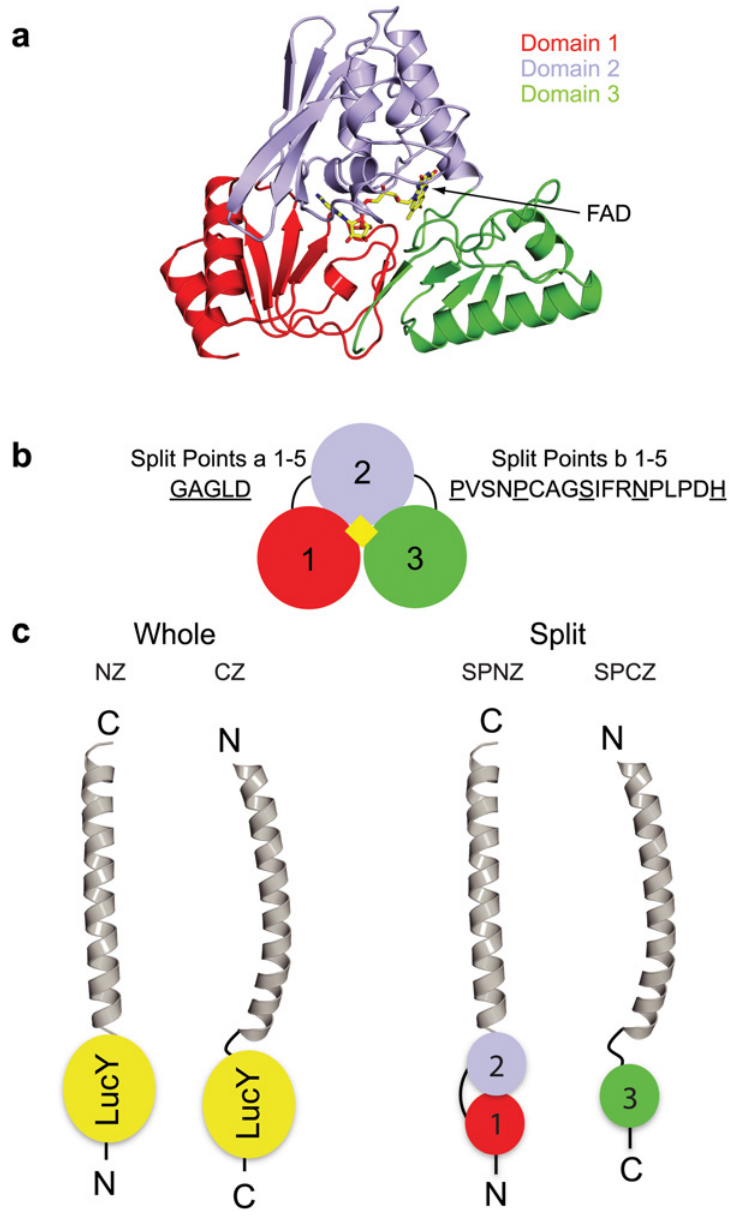
Fig 4. LucY PCA System. (a) LucY is divided into 3 distinct domains (colored red, blue, and green) with (b) a five residue loop connecting domains 1 and 2 and an approximately 18 residue loop connecting domains 2 and 3. Five points within each of these loops were chosen as Split Points (SP) (underlined). (c) Synthetic antiparallel leucine zippers (gray) were used as protein interaction models to test reconstitution of LucY PCA fragments (right) and were compared to whole LucY fusions (left). LucY fused at the N-terminus of the leucine zipper is referred to as NZ, and LucY fused at the C-terminus is